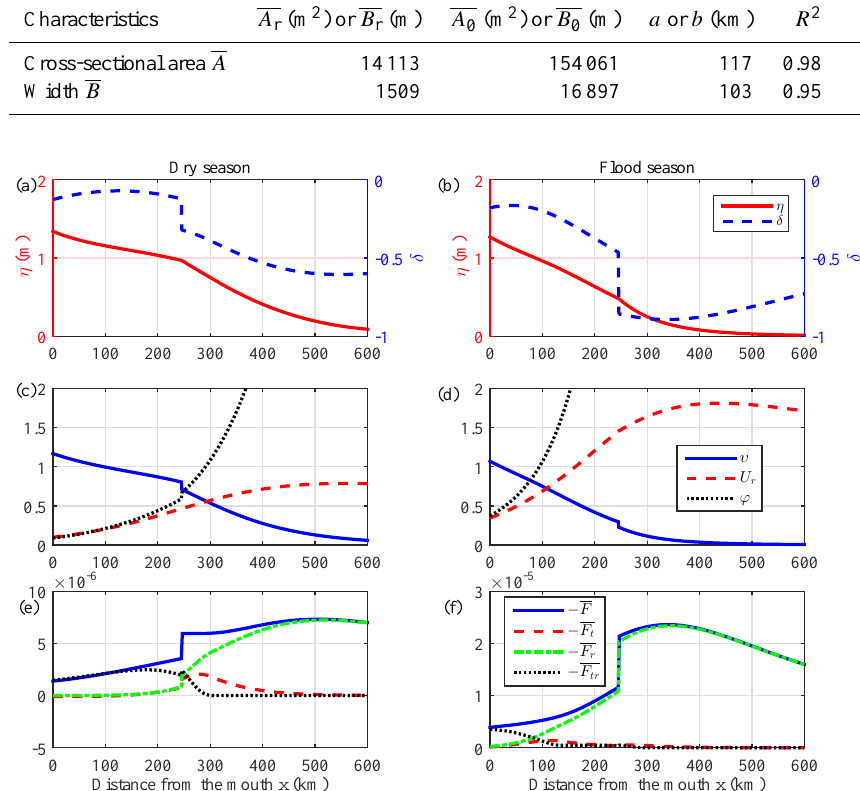
Figure 11. Longitudinal variation of the tidal amplitude and corresponding damping number (a, b) , the contributions to the flow velocity by river and tide (c, d) , and contributions of river flow and tide to the water level slope (e, f) for the dry (a, c, e) and flood season (b, d, f) in the Yangtze estuary, in which the results are the averaged values during 6–26 February 2012 (representing the dry season) and during 10–26 August 2012 (representing the flood season),